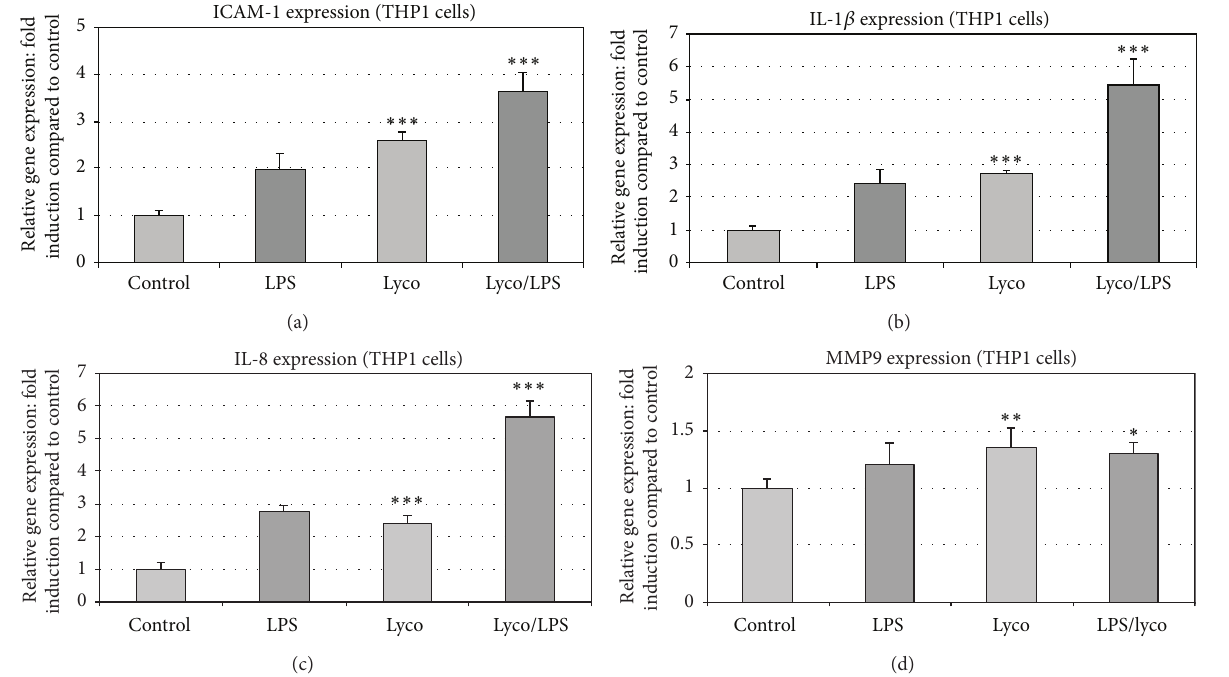
Figure 1: Lycopene modulates basal and LPS-induced inflammatory gene expressions in THP1 cells. ICAM-1 (a), IL-1 𝛽 (b), IL-8 (c), and MMP9 (d) gene expression was studied in THP1 cells treated with LPS. Modulation of this expression was studied in THP1 cell cultures pretreated for 2 h with or without lycopene (2 𝜇 M). Then, according to assays, LPS (100ng/mL) was added for 6h and mRNA expression was analyzed by RT-qPCR. Values are means ± SD ( 𝑛 = 8 ). Assays treated with lycopene were compared to corresponding assays without lycopene. ∗∗∗ 𝑃 < 0.01 ; ∗∗ 𝑃 < 0.05 ; ∗ , nonsignificantly